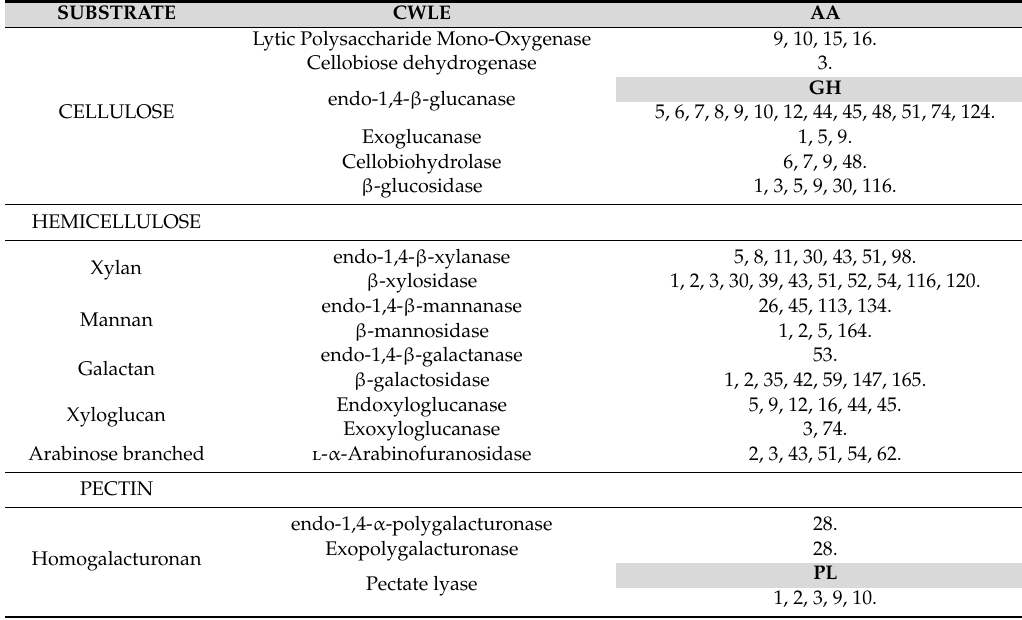
Table 1. Distribution of conserved domains in major cell wall lytic enzymes (CWLE) families. Auxiliary activity (AA), polysaccharide lyase (PL), and glycoside-hydrolase (GH) domains are